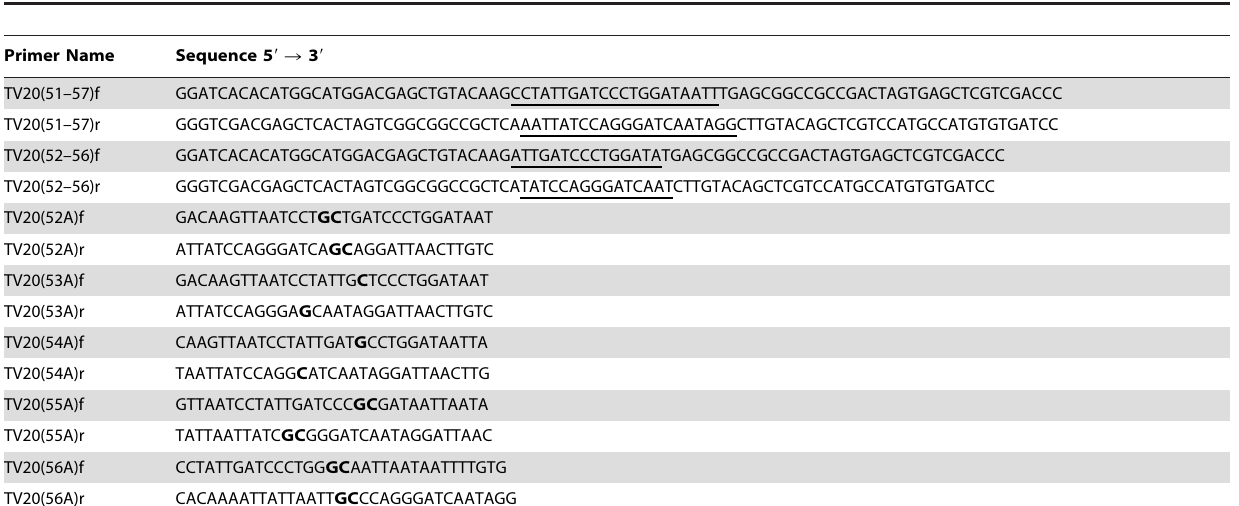
Table 1. Primers used for cloning and site-directed mutagenesis*